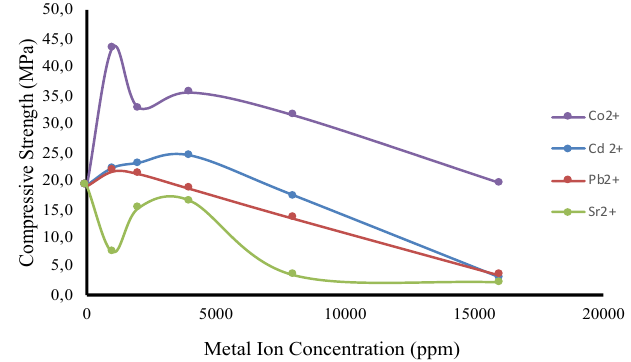
Fig. 4. The compressive strength of geopolymer and heavy metal-geopolymer The immobilization of heavy metal cations was estimated to affect the formation of the basic structure of the geopolymer. Fig. 3. Microstructure of fly ash from PT. IPMONI